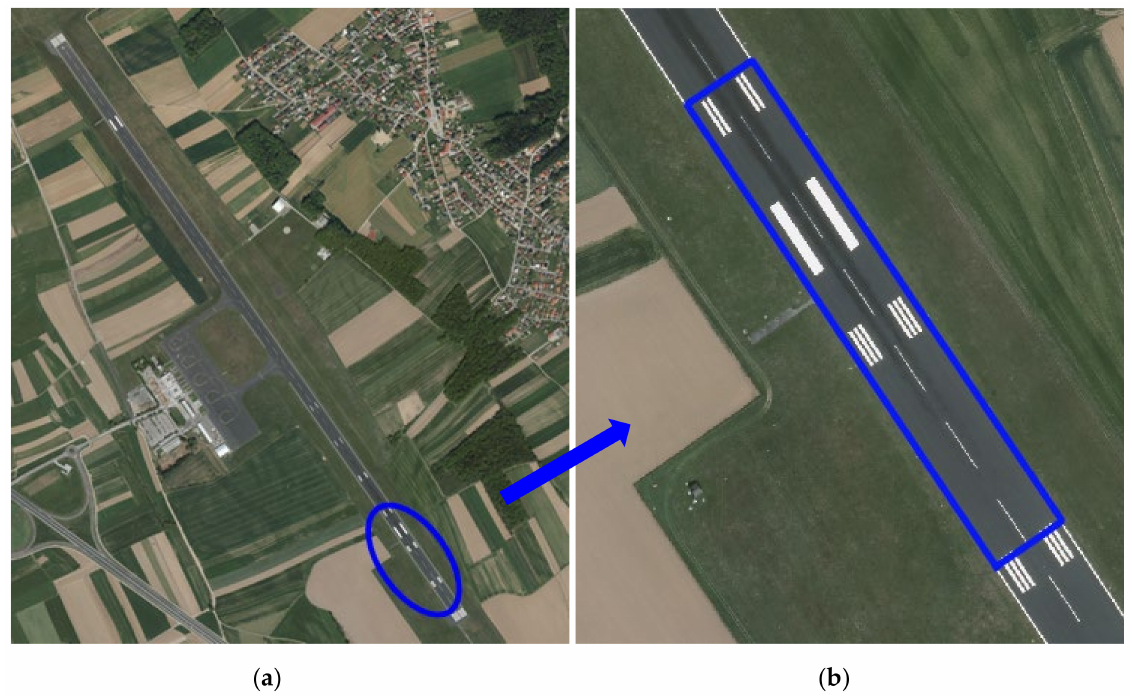
Figure 6. The runway: ( a ) the measurement area; ( b ) the touchdown zone.